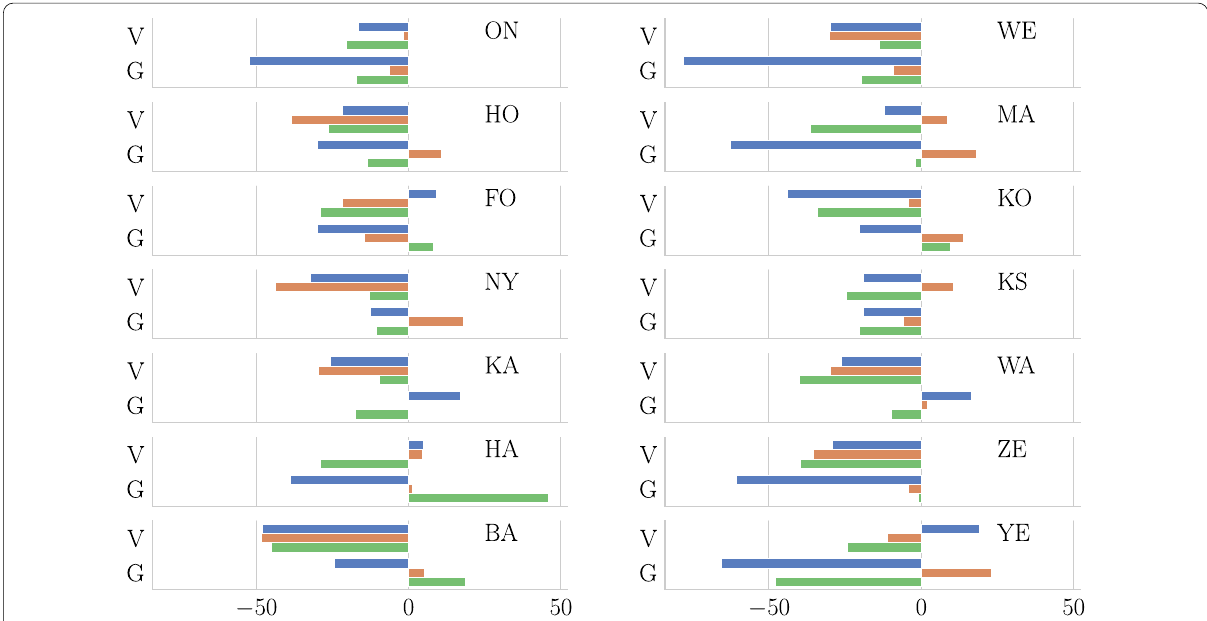
Fig. 8 Relative change in repeatabilities (%) per station for the two co‑located networks between between sol‑V and sol‑VG as well as sol‑G and sol‑VG. Negative repeatability changes mean that the combined solution lowers the repeatability, i.e., improvement. The components evaluated are north (blue), east (orange) and up (green) of the local topocentric frame